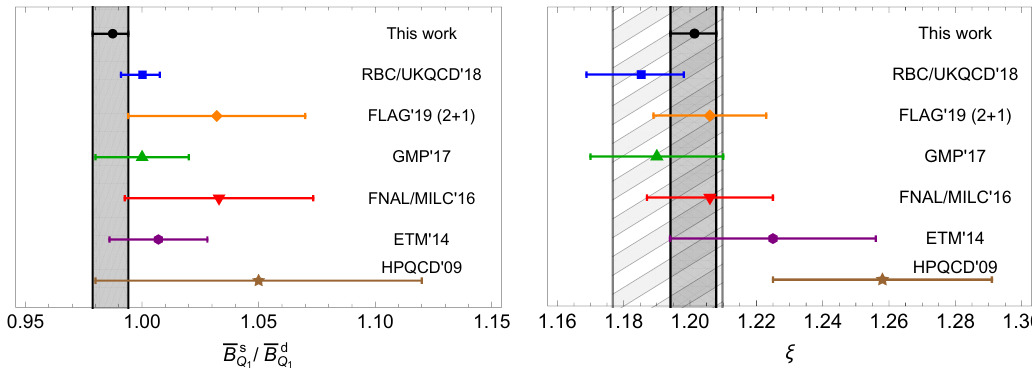
Figure 5 . Comparison of the ratios B s ture [11, 12, 14, 17, 18, 45]. On the right side we also show our result obtained using the FLAG N f = 2 + 1 average for the ratio of the decay constants as a hatched band. The GMP’17 [14] value for (cid:24) corresponds to eq. (5.9) of that paper where the world average for f B